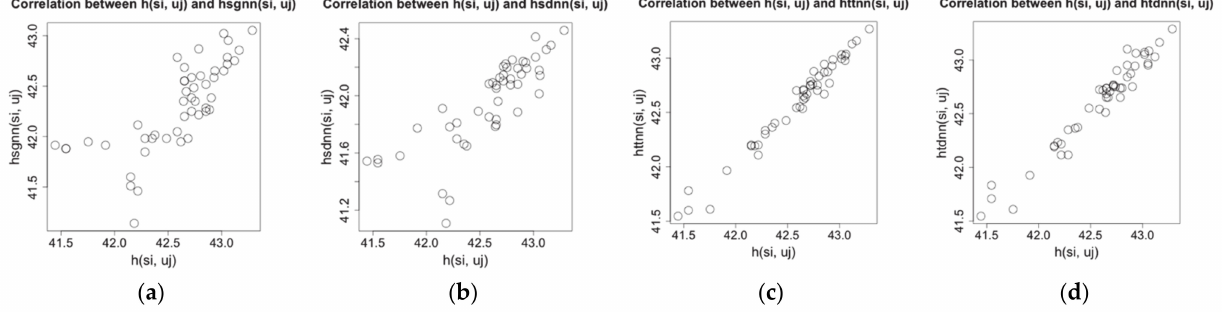
Figure 2. Correlation between raw humidity values and spatial (temporal) nearest neighbor values on Intel Lab